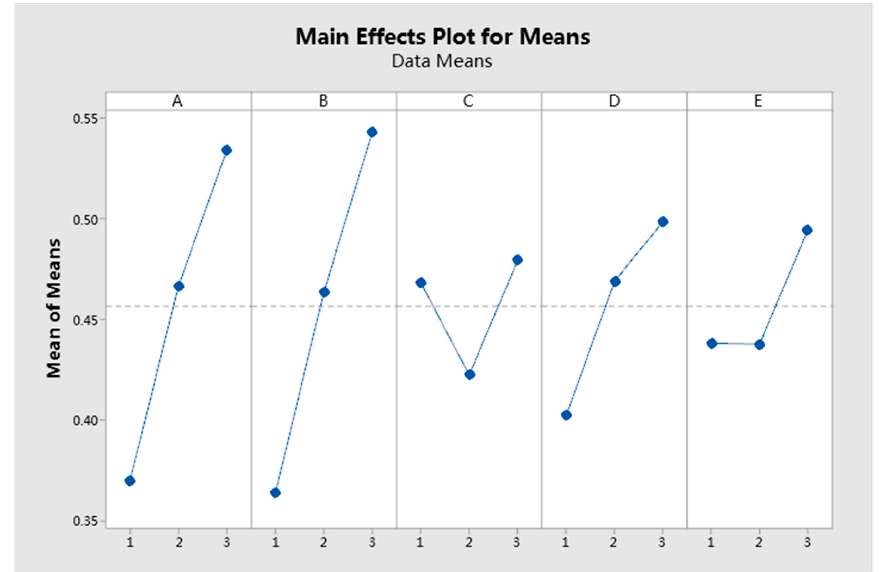
Figure 5. NSGA-II main effects plot for means. Table 2. Tuning results for the parameters of the algorithm.